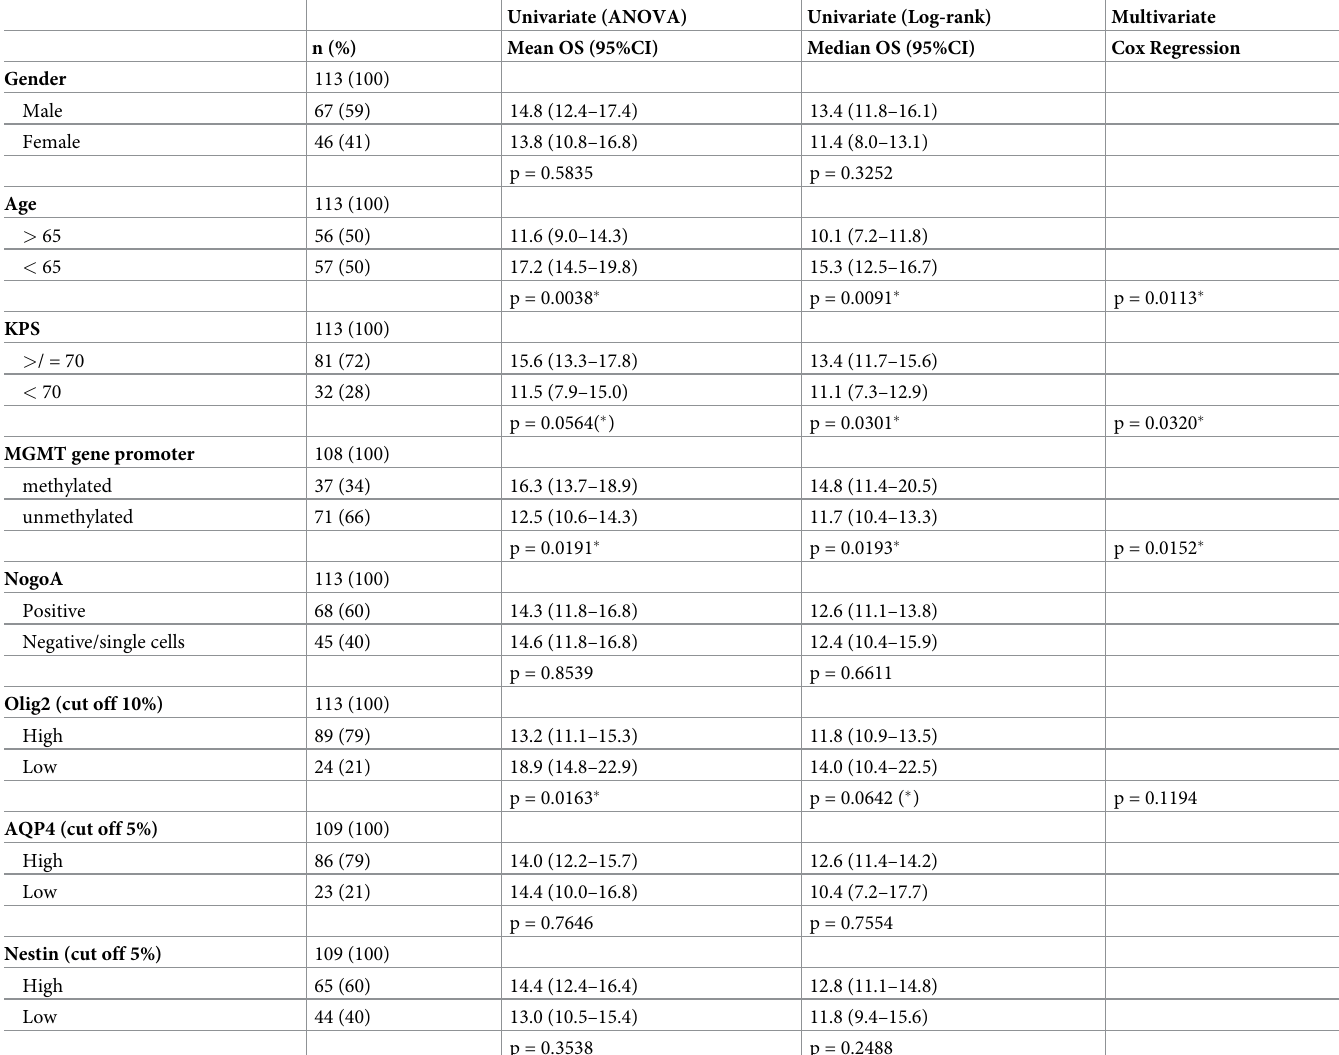
Table 3. Survival